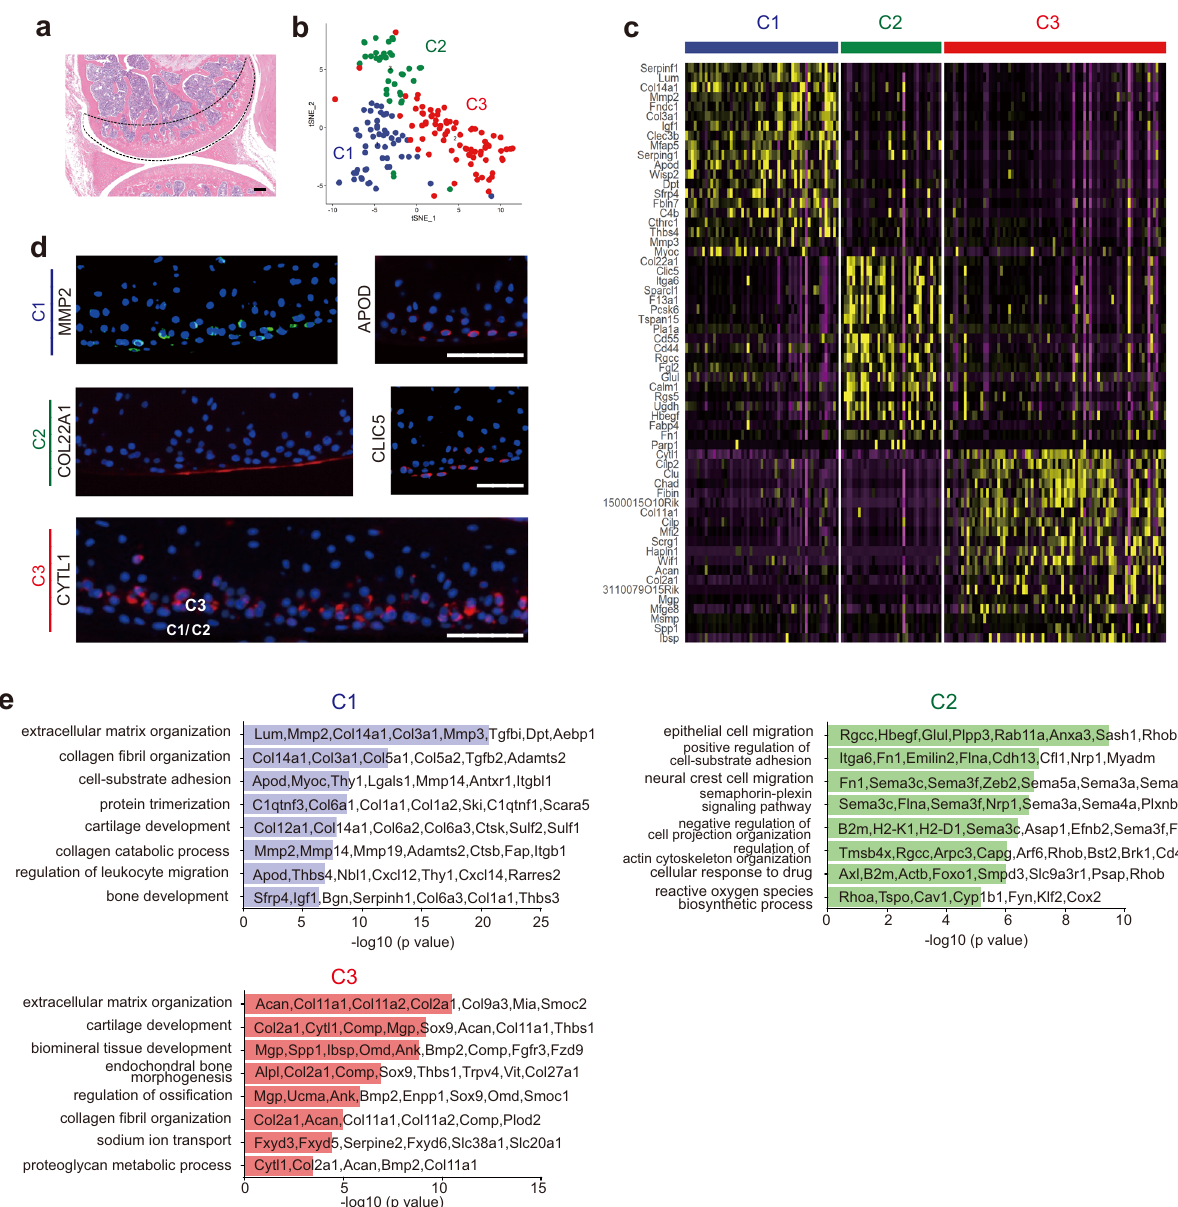
Fig. 5 scRNA-seq analysis identi fi ed three subsets of chondrocytes. a Medial femoral condyle tissue from the region enclosed by the dotted lines was isolated for cell dissociation. n = 9 mice. Scale bar, 250 μ m. b Putative chondrocyte population (171 cells) and unsupervised clustering identi fi ed clusters C1, C2, and C3 in cartilage. c Heatmap showing the expression of the top 20 identi fi ed signi fi cantly differentially expressed genes in clusters C1, C2, and C3. d Immuno fl uorescence staining of representative markers identi fi ed by scRNA-seq in articular cartilage. n = 3 independent experiments. All scale bars, 100 μ m. e GO analysis and representative genes for clusters C1, C2, and